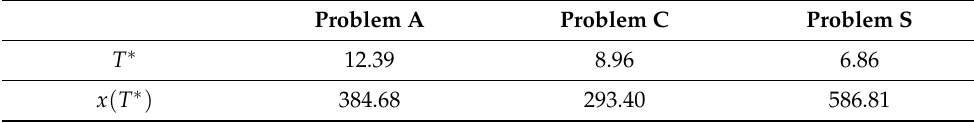
Table 1. Switching time and resource stock at the time of the